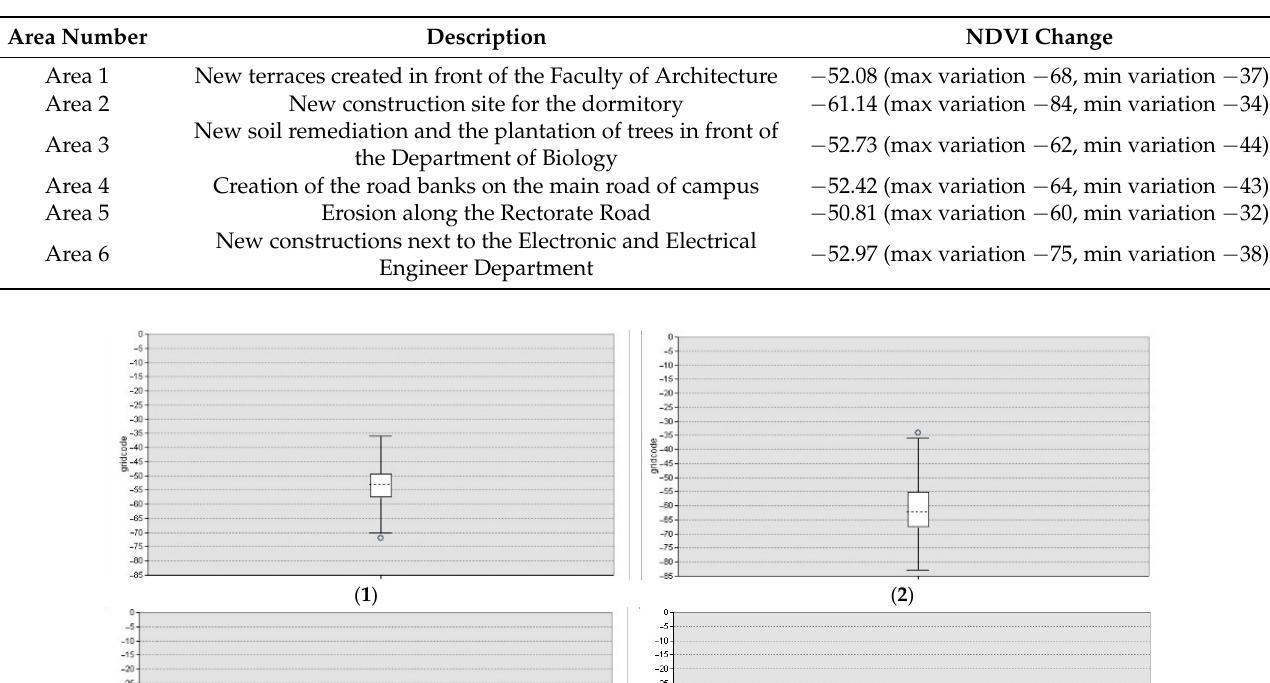
Figure 10. New construction next to the Electronics and Electrical Engineering Department. Table 2. Synthesis of the Areas description.